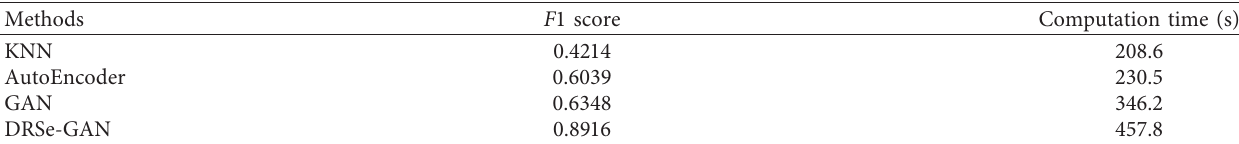
Table 7: Test results of different